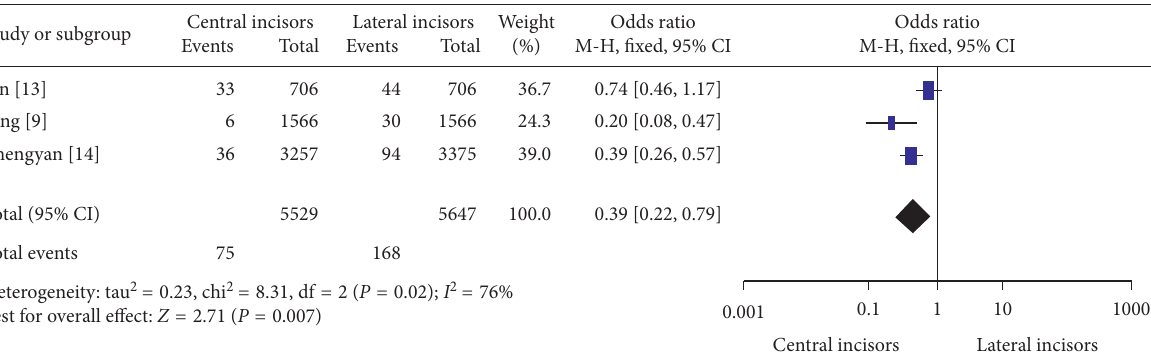
Figure 3: The evidence of second canal configurations (Vertucci’s Types ΙΙ , Ι V, V V ΙΙ , ΙΧ , and Χ ) except Vertucci’s Type ΙΙΙ between permanent mandibular central and lateral incisors in